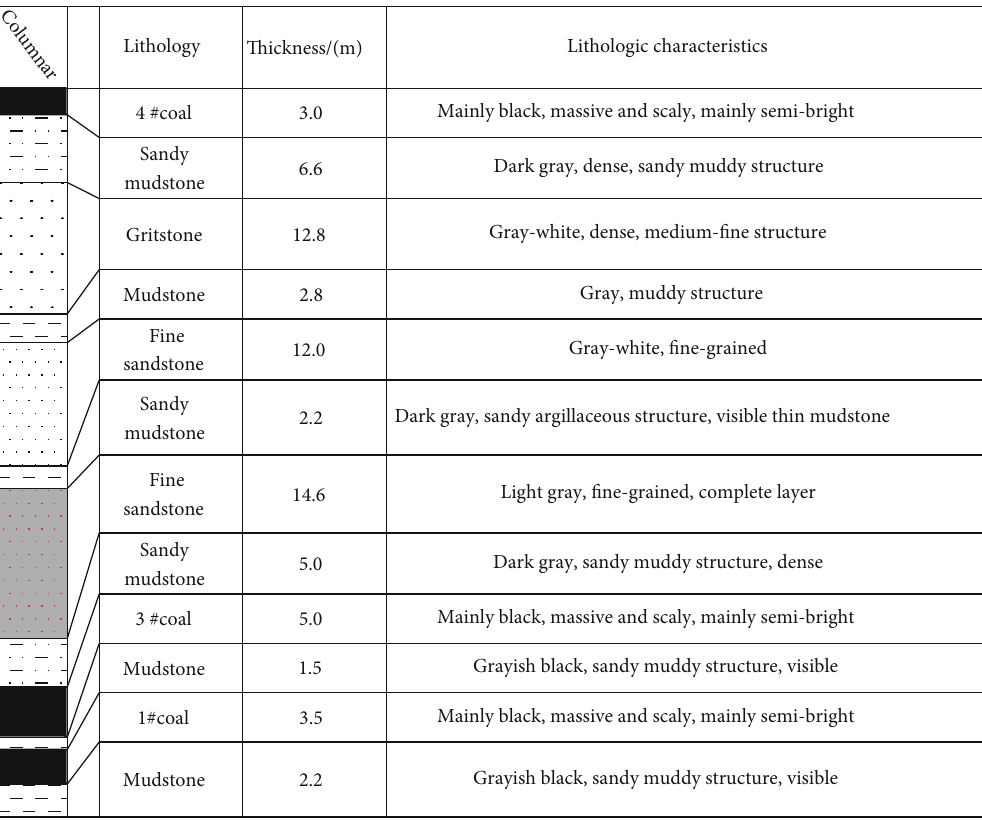
Figure 2: The rock column diagram of the